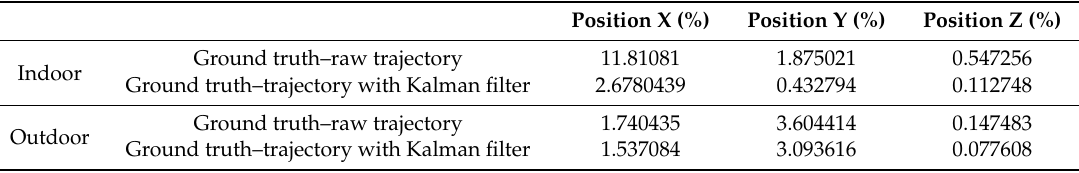
Table 1. Standard deviation in the comparison of the ground truth, raw trajectory data, and trajectory with the Kalman filter.